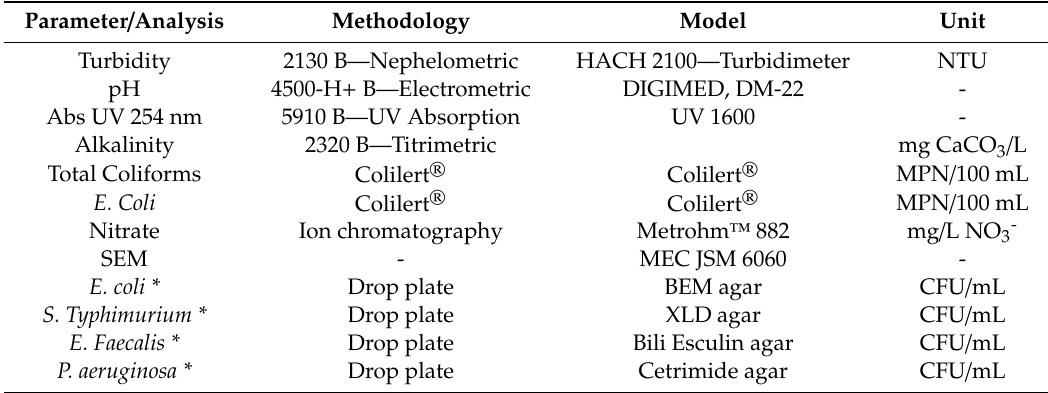
Table 1. Equipment and materials used for the water quality analysis.